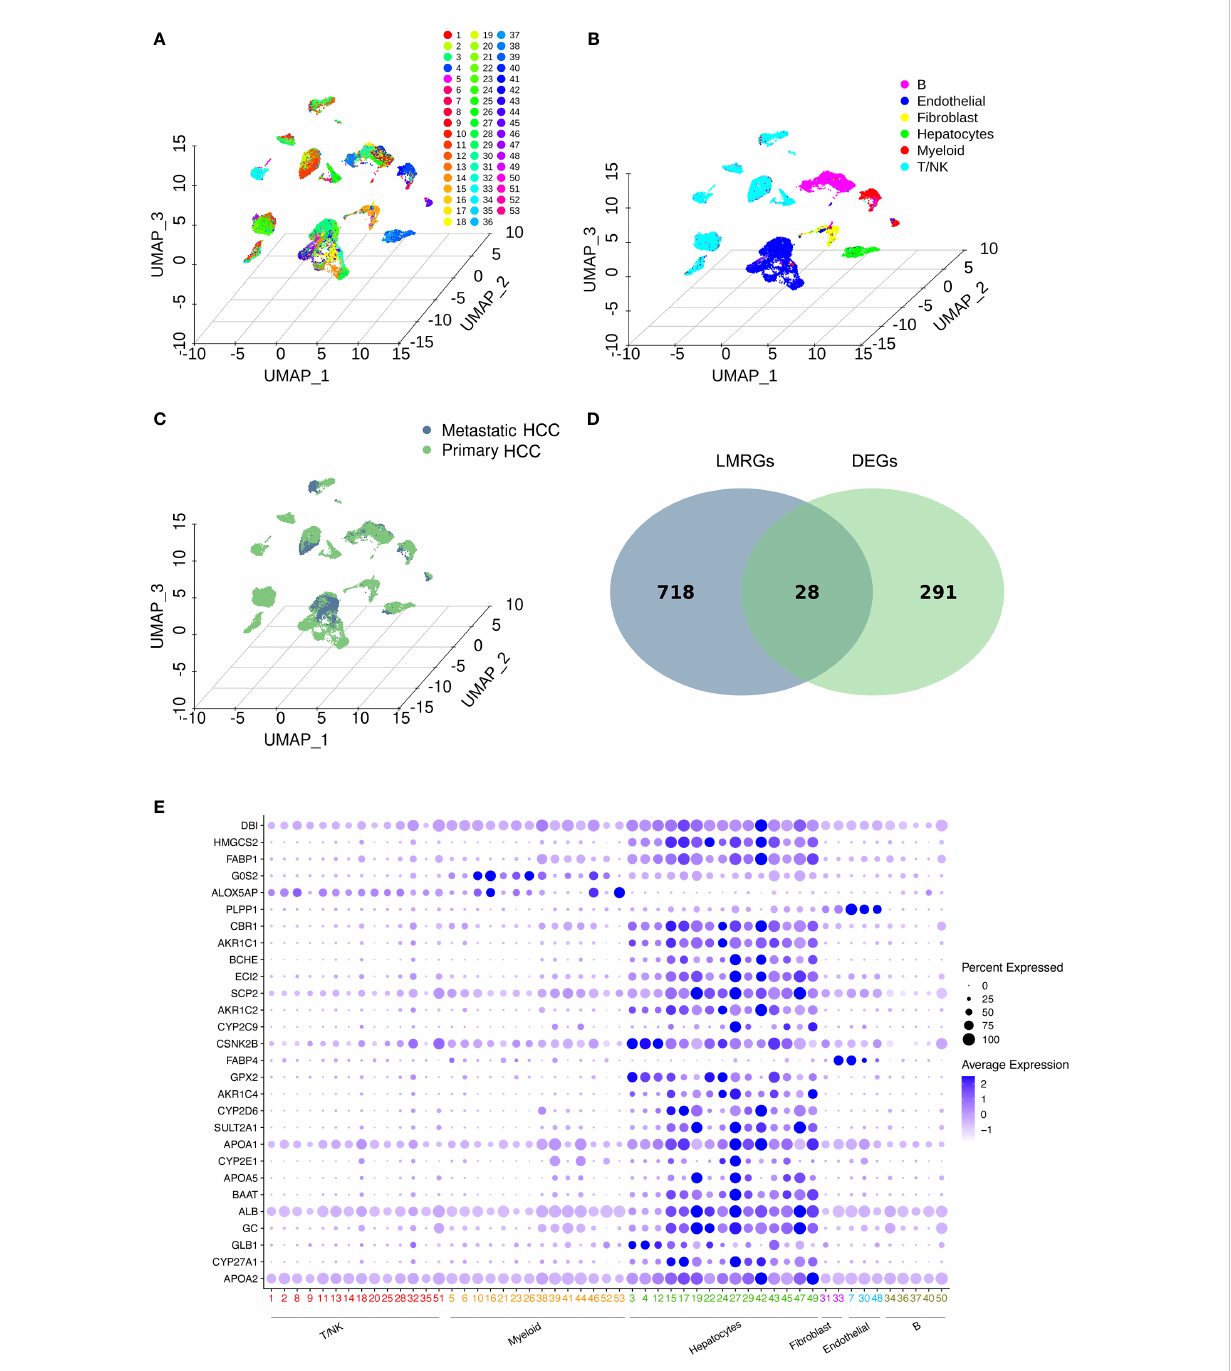
FIGURE 2 Data pro fi ling of the GSE149614 cohort by scRNA-seq. (A-C) Samples from primary and metastatic hepatocellular carcinoma (HCC) tissue clustered by the UMAP algorithm. The dimension reduction showed the results of (A) 53 clusters, (B) six major cell types, and (C) primary and metastatic HCC. (D) Identi fi cation of lipid metabolism-related genes (LMRGs) in HCC development. A total of 746 LMRGs were assessed in the Reactome Pathway Database (https://reactome.org/). A total of 319 differentially expressed genes (DEGs) between primary and metastatic HCC samples were used to intersect with the 746 LMRGs. Finally, 28 screened LMRGs were identi fi ed. (E) Dot plot showing the expression of 28 LMRGs in different cell